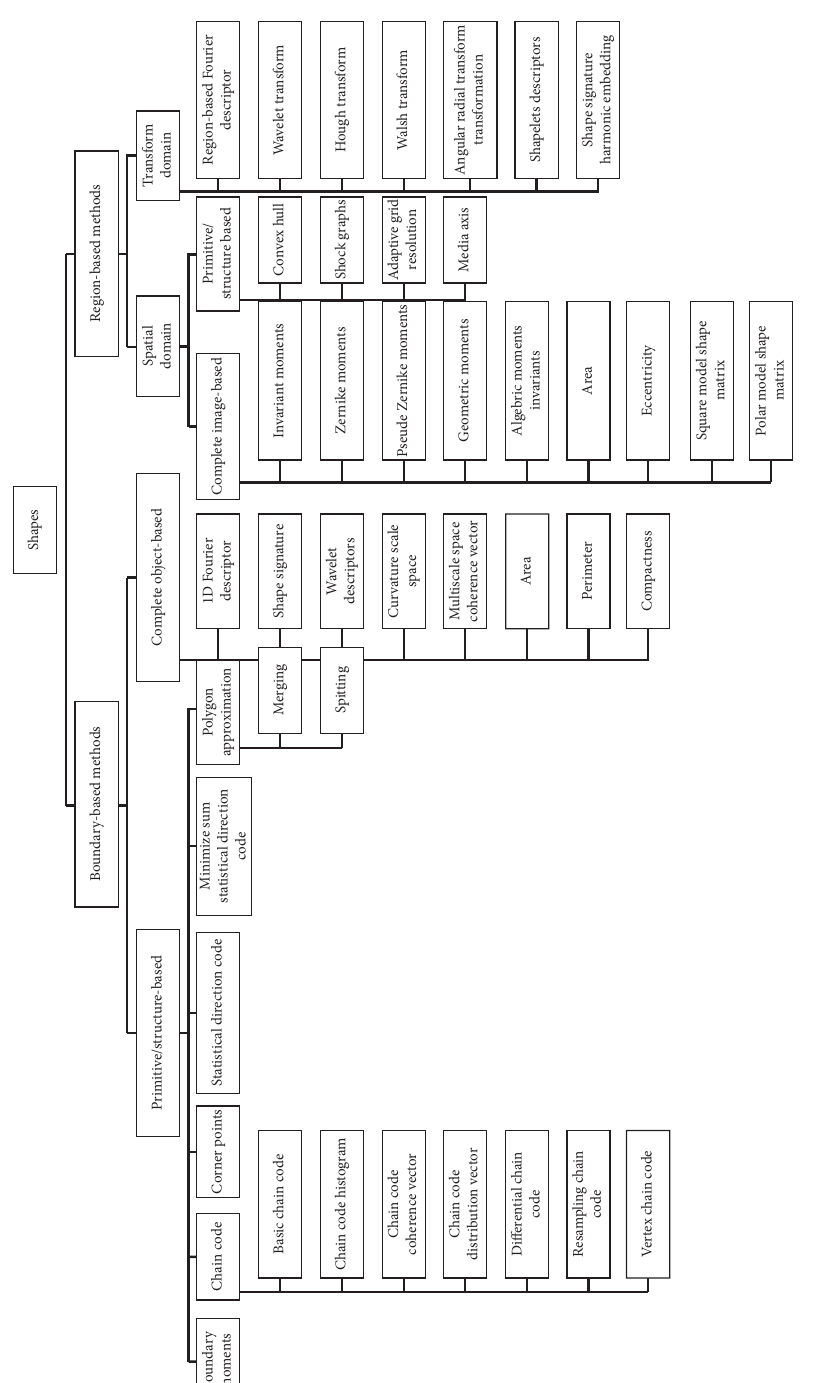
Figure 2: Classification of shape feature extraction and description techniques The Harris and Shi-Tomasi corner detectors are not so The Shi and Tomasi corner detector works faster than the useful for searching similar images of various sizes and scales Harris corner detector. It works in a similar manner as the as they are very unstable to scale change. In [52], a low-level Harris corner detector with a slight change in conditions to feature detector SUSAN based on a circular mask is pre- detect a region as a corner. If the CR value is greater than the sented. SUSAN is fast and accurate to detect lines, edges, and threshold, then the region is detected as a corner [49]. corners with noise reduction. In [54], the Laplacian of CR � min ( α , β ) . ( 16 ) Gaussian is approximated with the difference of Gaussian.